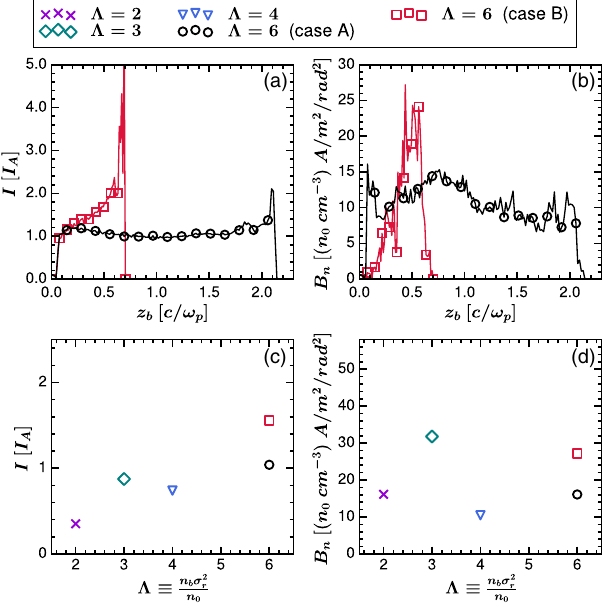
FIG. 4. The beam slice parameters of the injected electrons for case A and case B: (a) the current, in units of the Alfven current I A and (b) the normalized brightness B n in units of − 3 Þ A = m 2 = rad 2 (cid:4) . The injected beams are subdivided into ½ð n 0 cm 128 (64) slices for cases A (B), respectively. (c) Slice current corresponding to the (d) peak normalized brightness of the injected electron beam as a function of the driver parameter Λ . Each marker corresponds to a unique simulation. Approximately 95% of injected electrons are used when calculating the beam parameters.